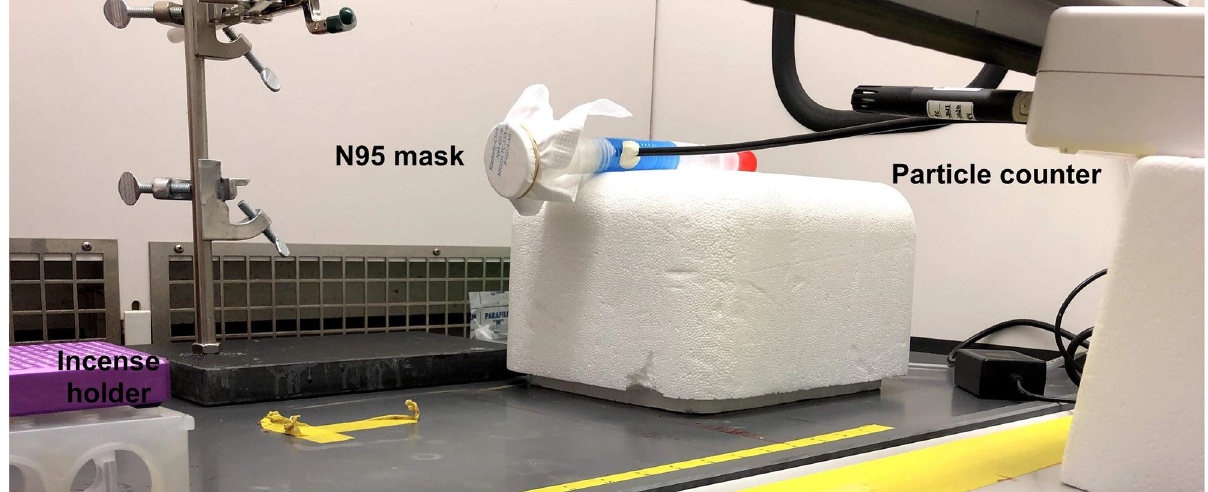
Fig 3. Filtering efficiency test setup to test filter efficiency of a N95 mask using LightHouse handheld particle counter to detect particles of size 0.3 μ m—10 μ m produced by burning an incense stick.